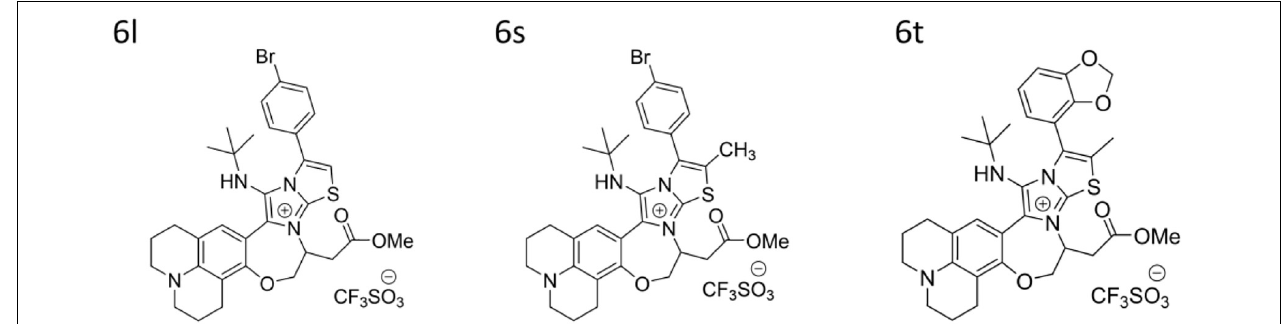
FIGURE 1 | Chemical structures of compounds 6l , 6s , 6t